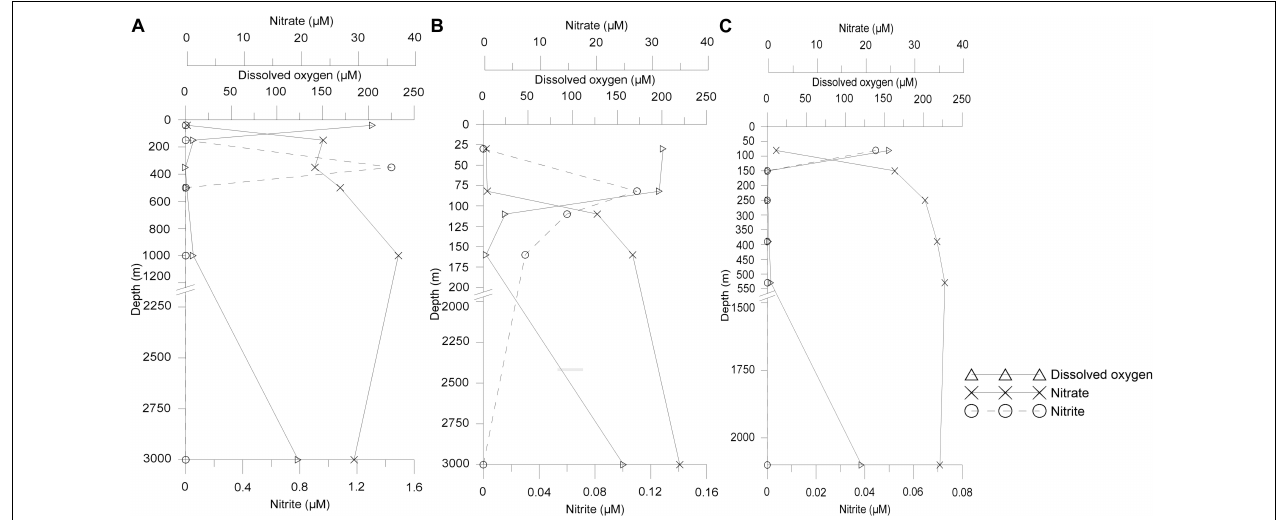
FIGURE 1 | Vertical distribution of concentrations of dissolved oxygen (DO), nitrate (NO 3 ), and nitrite (NO 2 ) from sampled depths at (A) Arabian Sea time series (ASTS), (B) India’s Idea 2 (II2), and (C) BoBTS.